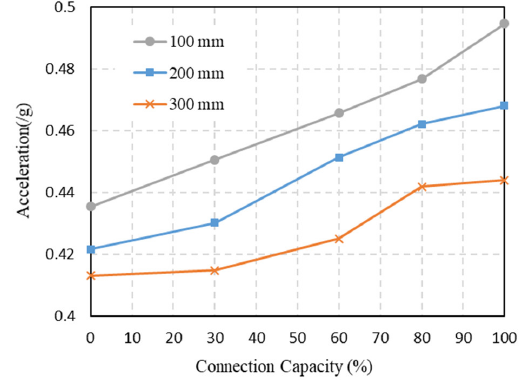
Figure 25. Peak acceleration of 15-story frames.